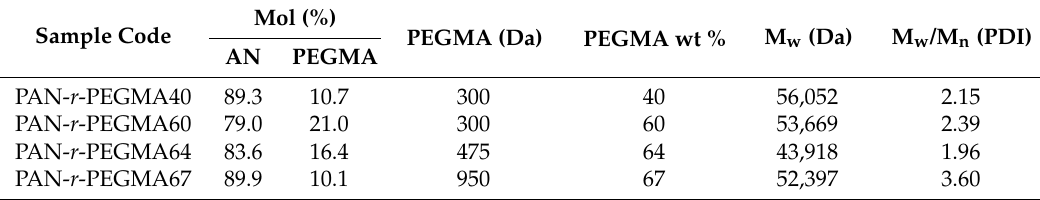
Table 1. PAN- r -PEGMA with various chemical compositions and their molecular